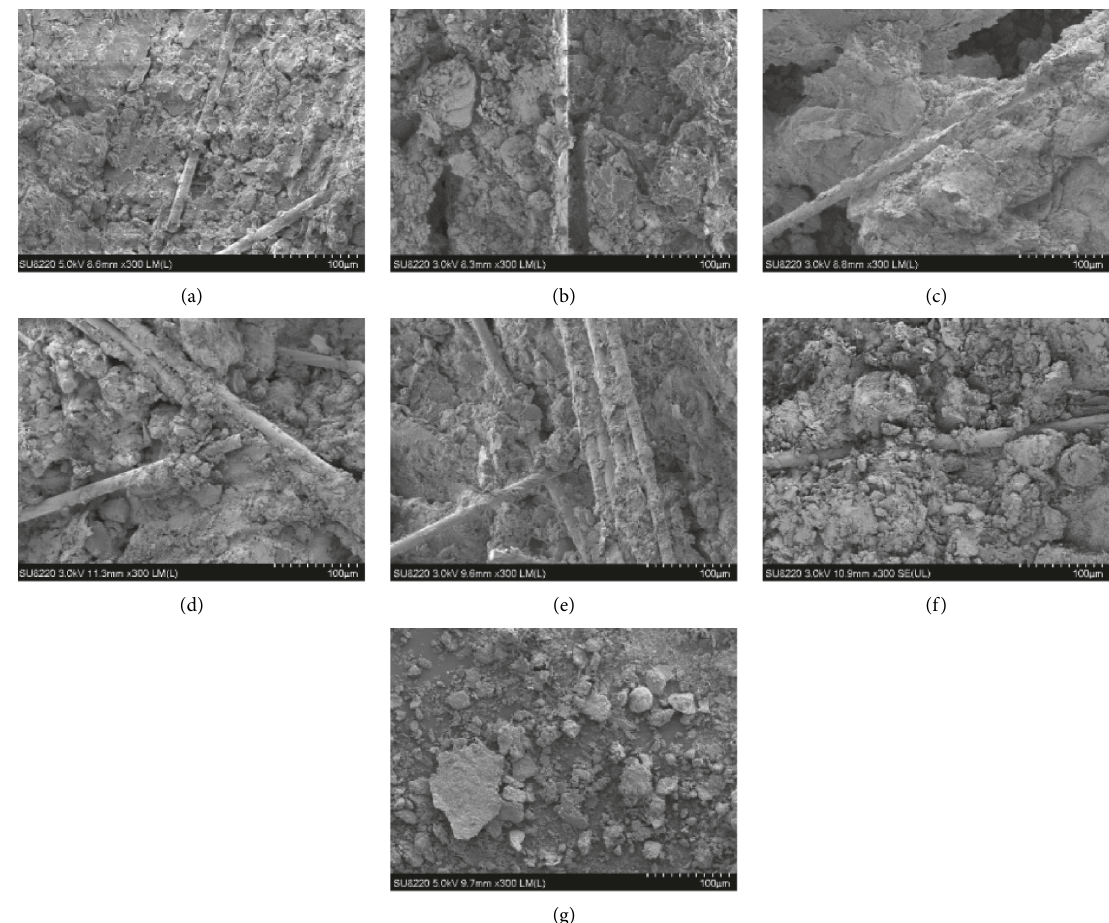
Figure 11: SEM of test soil magnification: 300. (a) F1. (b) F2. (c) F3. (d) G1. (e) G2. (f) G3. (g) H.